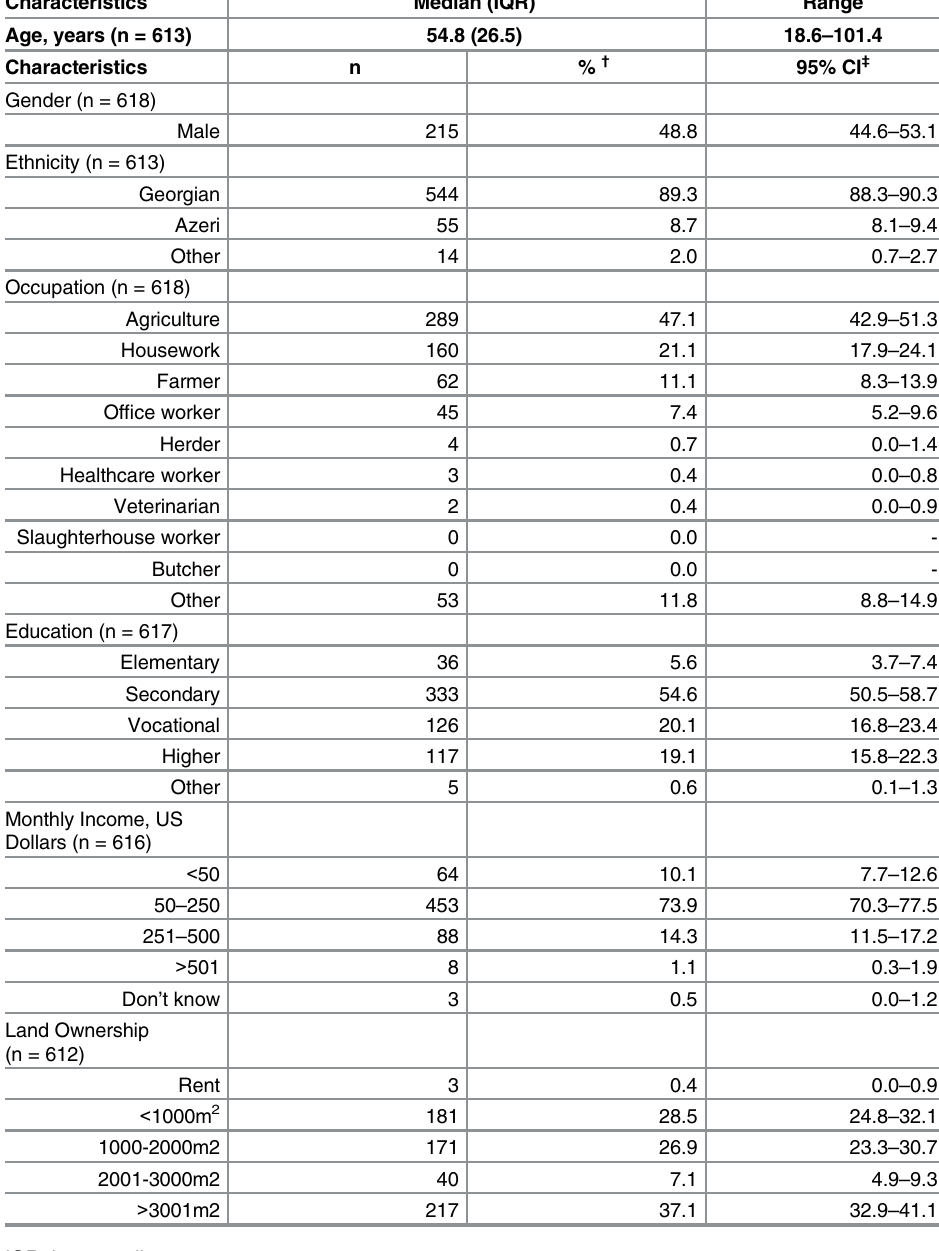
Table 1. Demographics of survey participants during an investigation of the 12 rural villages with reporting at least one 2014 Crimean-Congo hemorrhagic fever case from January to September 2014 in